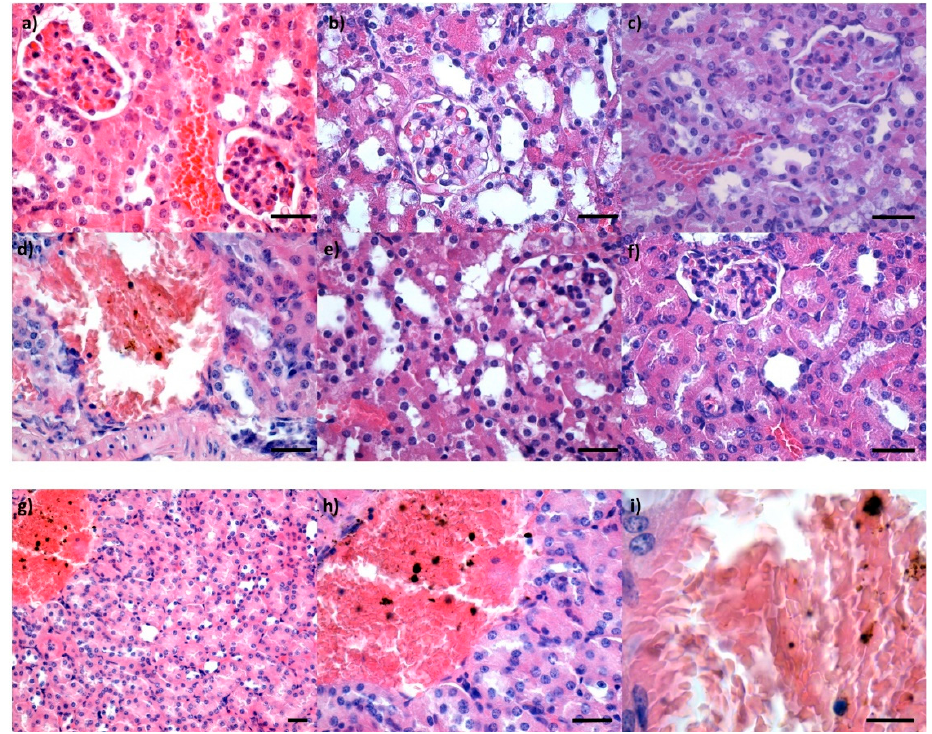
Figure 8. Cross-section through a kidney from mice injected with Fe 3 O 4 ( a , d ), Fe 3 O 4 @PEG 20 K ( b , e ) and Fe 3 O 4 @PEG 35 K NPs ( c , f ), respectively, and harvested at 2 days ( a – c ) and 10 days ( d – f ), respectively, after intravenous administration; Hematoxylin–Eosin staining; 400× magnification, scale bar 50 μ m; figures ( g – i ) represent details of cross-section through kidney from mice injected with Fe 3 O 4 NPs and harvested at 10 days after intravenous administration; Hematoxylin–Eosin staining; different magnifications: ( a ) 200×, scale bar 50 μ m; ( b ) 400×, scale bar 50 μ m; ( c ) 1000×, scale bar 25 μ m.